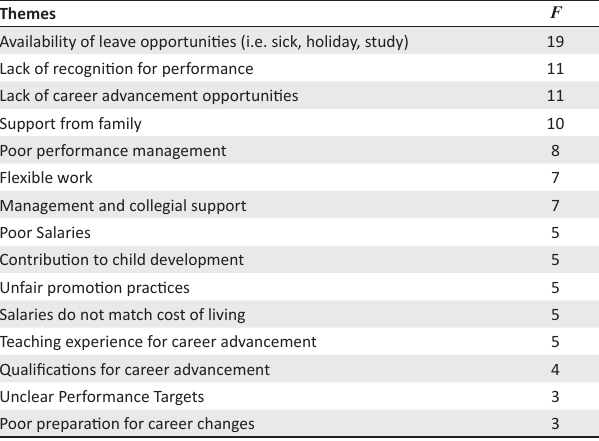
TABLE 1: Themes deduced from the participants. Themes